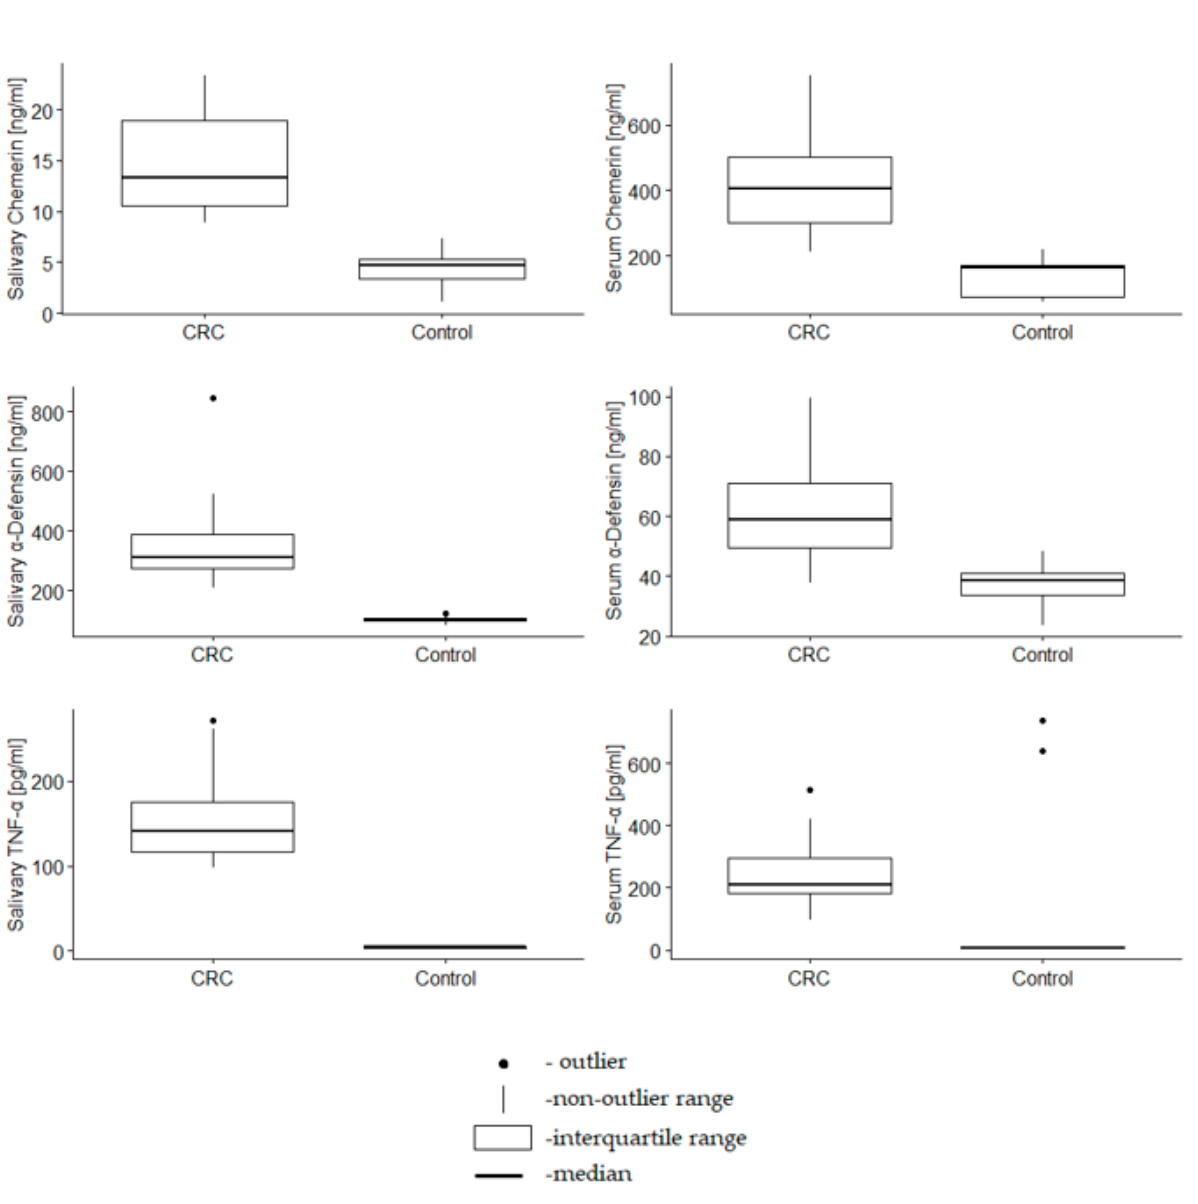
Figure 1. Serum and salivary concentrations of chemerin, α -defensin 1 and TNF- α in CRC patients and control group. Table 4. Comparison of serum and salivary concentrations of chemerin, α -defensin 1, and TNF- α in all groups depending on